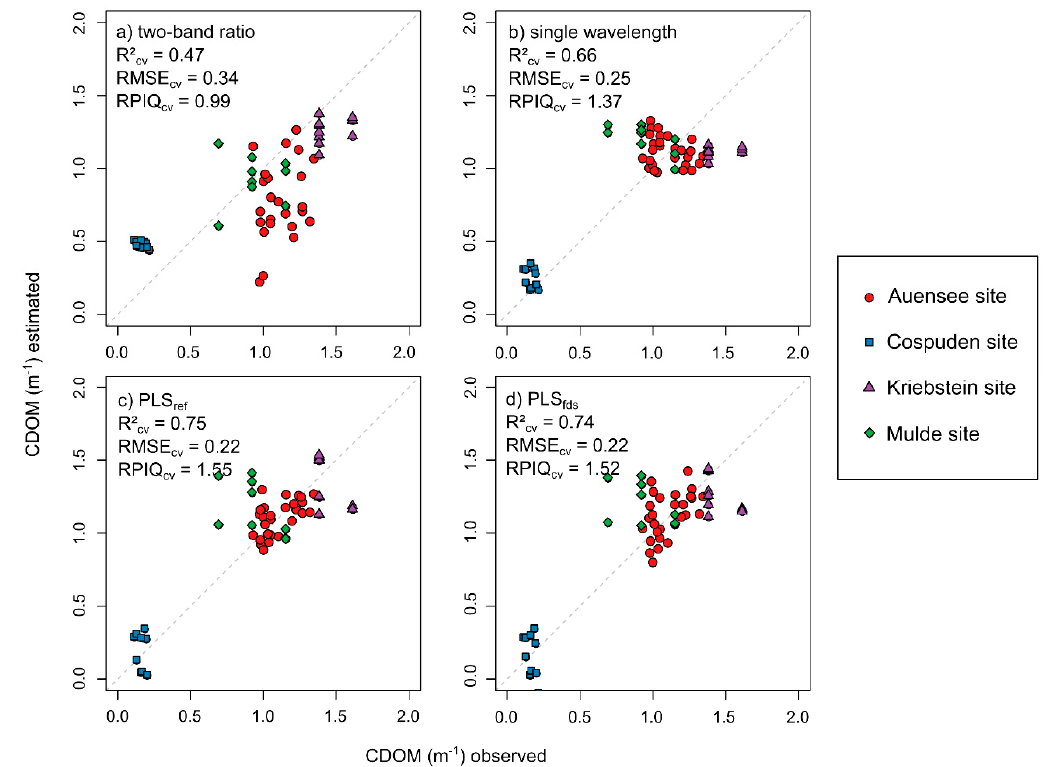
Figure 10. Measured and cross-validated prediction values of CDOM with error metrics based on the entire dataset: ( a ) two-band ratio, ( b ) single wavelength at 602 nm of first derivative, ( c ) PLS ref = PLS regression based on reflectance spectra, and ( d ) PLS fds = PLS regression based on first derivative spectra. The dashed line represents the 1:1 line.